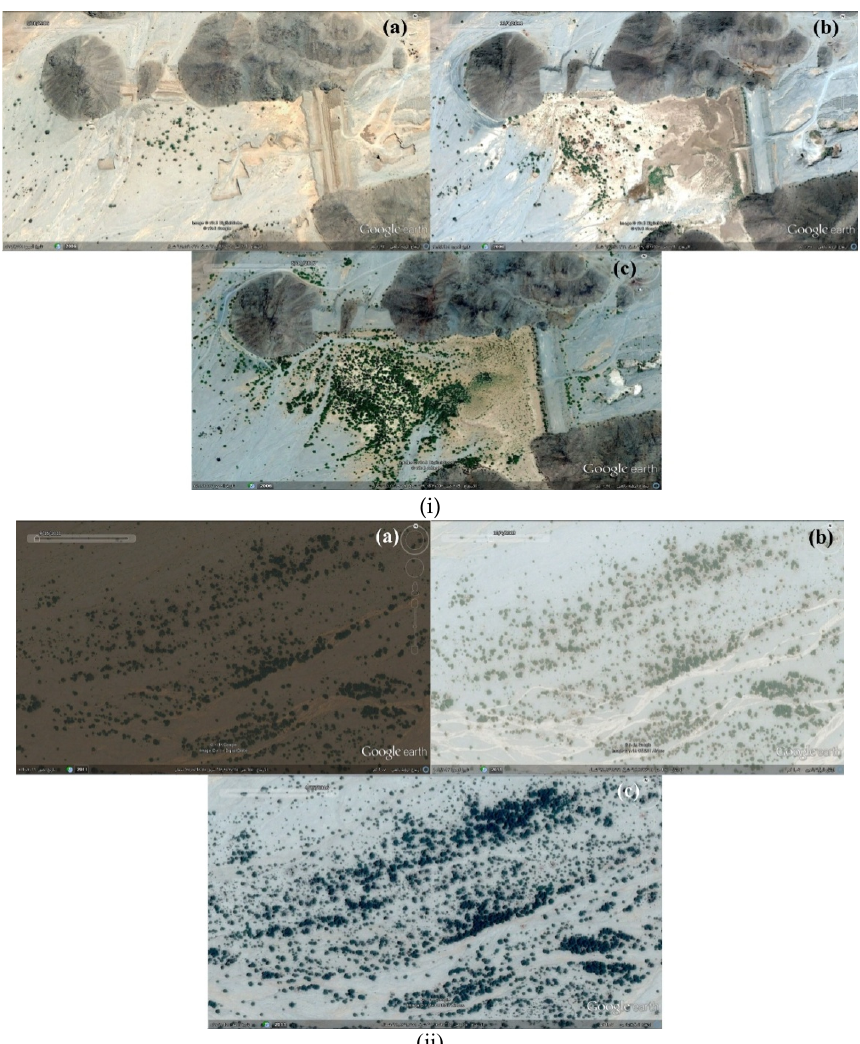
Figure 5. Satellite images showing changes in vegetation coverage in different areas. ( i ) Vegetation change in a rainwater harvesting area during (a) 2006, (b) 2011 and (c) 2017 (Source: Google Earth). ( ii ) Vegetation change in the Erkwit area during (a) 2011, (b) 2013 and (c) 2016 (Source: Google Earth).